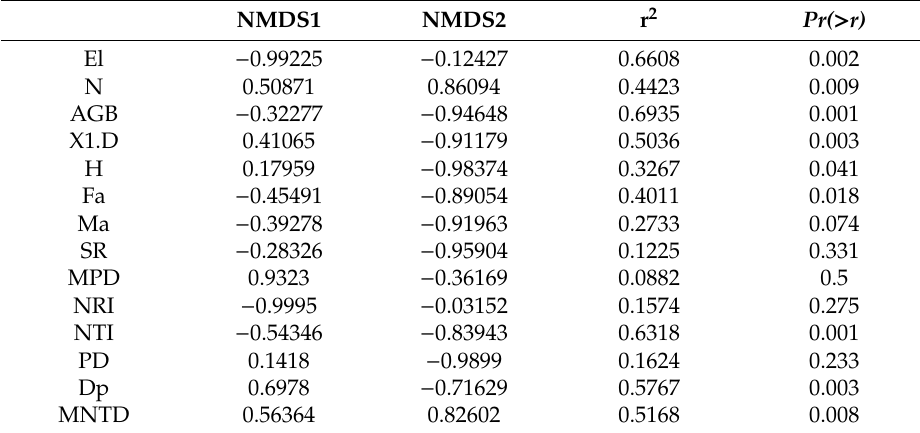
Table A1. NMDS ordination of the compositional structure of three forest